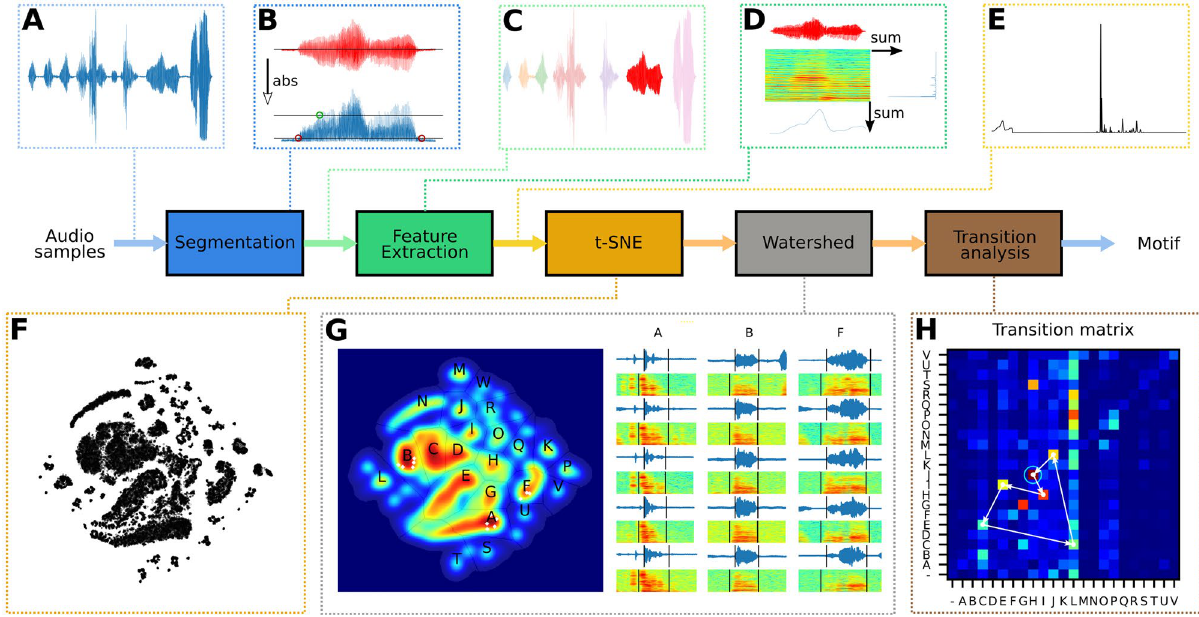
Figure 4. Unsupervised training of motif detector pipeline. ( A ) The raw sound signal is received as a continuous stream. ( B ) When the absolute value of the samples crosses the high threshold, we search back and forth for onset and offsets based on crossing of the low threshold. ( C ) The segmented signal. ( D ) A spectrogram of the sound is generated and two vectors are computed by summing the rows and columns, respectively. ( E ) The two vectors are normalised and concatenated to a 746-dimensional feature vector. ( F ) Dimensionality reduction of 60k feature vectors into a 2D space shows that sound segments cluster together. ( G ) Regions of stereotyped sounds are labelled. Examples of randomly picked sounds from three different regions are indicated by white dots on the density plot and with oscillograms and spectrograms on the right. Each column is a different region. ( H ) The most common song motif is extracted by forming the transition probability matrix and following the most likely transitions forming a loop. The loop represents the most stereotyped sequence and is defined as the motif.